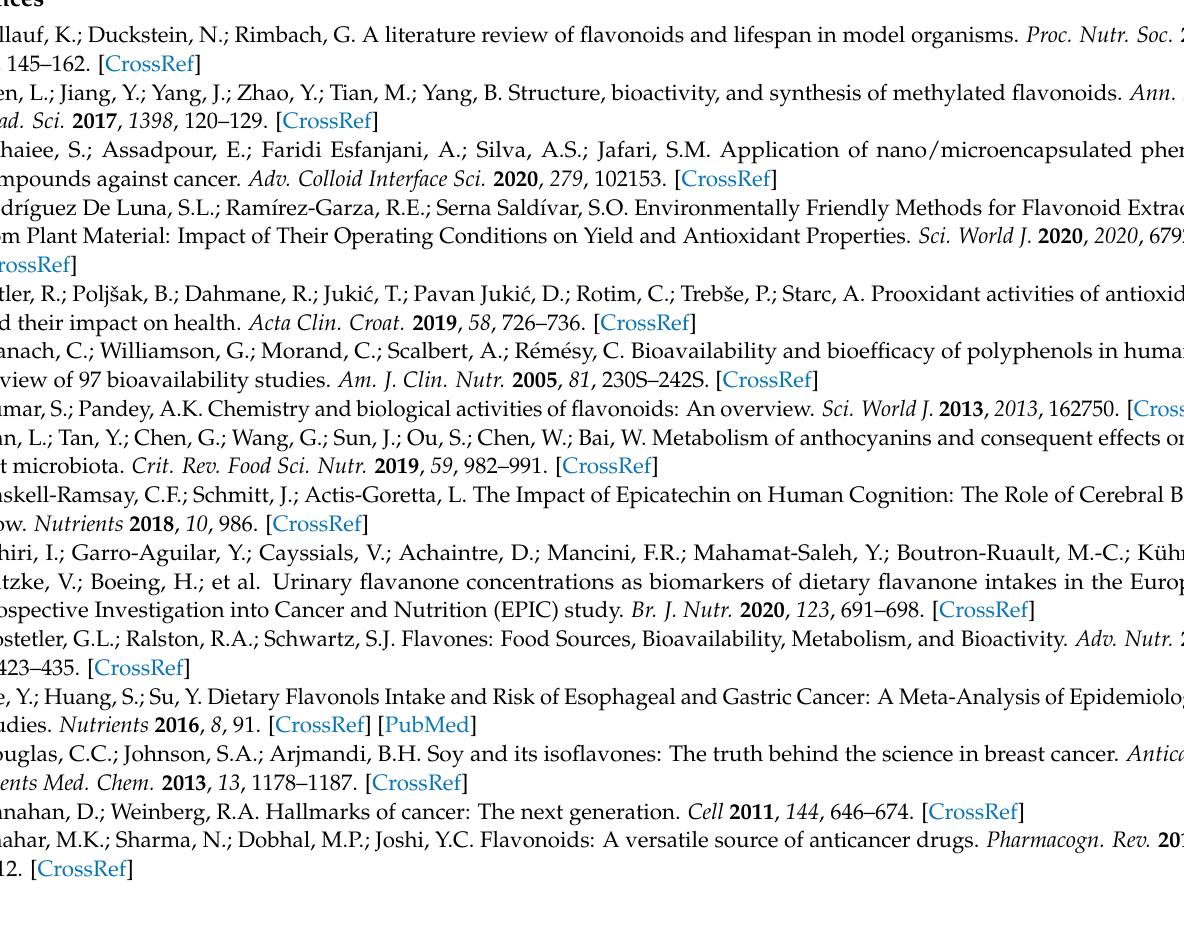
Figure 5. M.C.S.M. wrote the apoptosis and cell cycle section and conceptualized Figure 6. R.M.N.B. and F.M.S. have conceptualized the review. All authors revised and approved the final version of